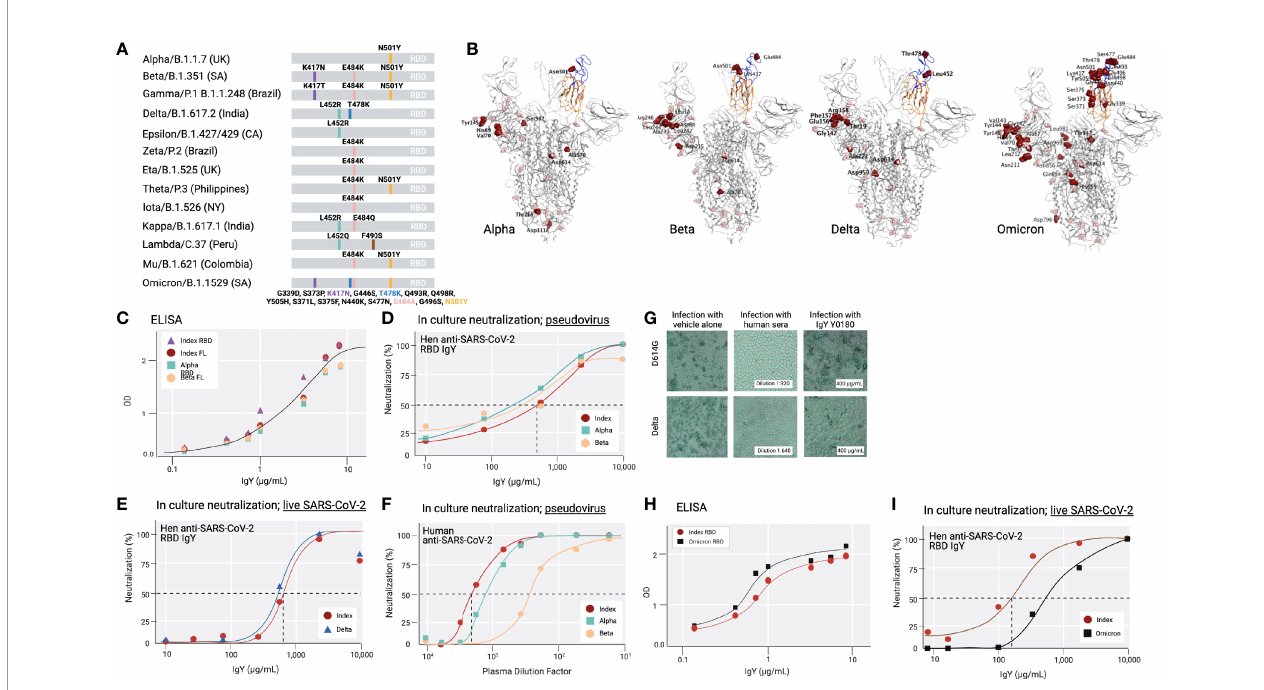
FIGURE 4 | Common SARS-CoV-2 variants and anti-SARS-CoV-2 IgY interaction with them (A) A scheme depicting locations of mutated amino acids in Alpha through Mu variants of SARS-CoV-2, focusing on the RBD domain only. Each color bar indicates the amino acid in the index virus that was mutated in the variant. (B) Spike protein of SARS-CoV-2 Alpha, Beta, Delta, and Omicron are shown from left to right. Molecular Operating Environment was used to create the fi gure (35). The location of mutations in the structure of the S protein trimer of SARS-CoV-2 (PDB ID: 7A98) for 4 of the common variants are indicated in red and glycosylation sites are indicated in pink throughout the S protein. Blue ribbon indicates RBD (amino acids 328-533), and the orange ribbon indicates receptor binding motif (amino acids 437-508). (C) Binding of anti-SARS-CoV-2 RBD IgY to recombinant S1 full length (FL) of the index virus, the RBD of the Alpha and Beta variants, and the immunizing RBD of the index virus by ELISA. (D) Neutralization of pseudovirus (VSV-S) SARS-CoV-2 carrying S protein of index virus, Alpha, or Beta variants by anti- RBD IgY. (E) Neutralization of live index or Delta viruses by anti-SARS-CoV-2 IgY against the RBD. (F) Neutralization of pseudoviruses listed in (D) by human serum of immunized individuals. (G) Neutralization of live D614G vs . Delta variants by human serum of immunized individual or by anti-SARS CoV-2 IgY. Microscopic evaluation of monolayers of Vero E6 cells after 96 hours infection with the indicated authentic (live) SARS-CoV-2 variant. Images from infected cells are shown after 4 days of infection with SARS-CoV-2 variants in the absence or presence of test items. Top three panels: Infection in the presence of MEX-BC2/2020 and bottom three panels: infection with the Delta variant each in the presence of vehicle alone, serum of a person immunized twice with the Moderna (mRNA-1273) vaccine or anti-SARS CoV-2 RBD IgY, as indicated, all at the indicated concentration (neutralization experiments in panels D-H & I were conducted by RetroVirox using pseudovirus or live virus, as indicated). (H) Binding of anti-SARS-CoV-2 RBD IgY to the index virus and Omicron variant (B.1.1.529) RBD domain using ELISA. (I) Neutralization of live index or Omicron variant of SARS-CoV-2 by anti-SARS-CoV-2 RBD IgY. Except when indicated, the studies were done over several months; therefore, the absolute titers in the ELISA and neutralization studies were not identical. However, each experiment included the same positive control; index RBD for ELISA and index virus for neutralization